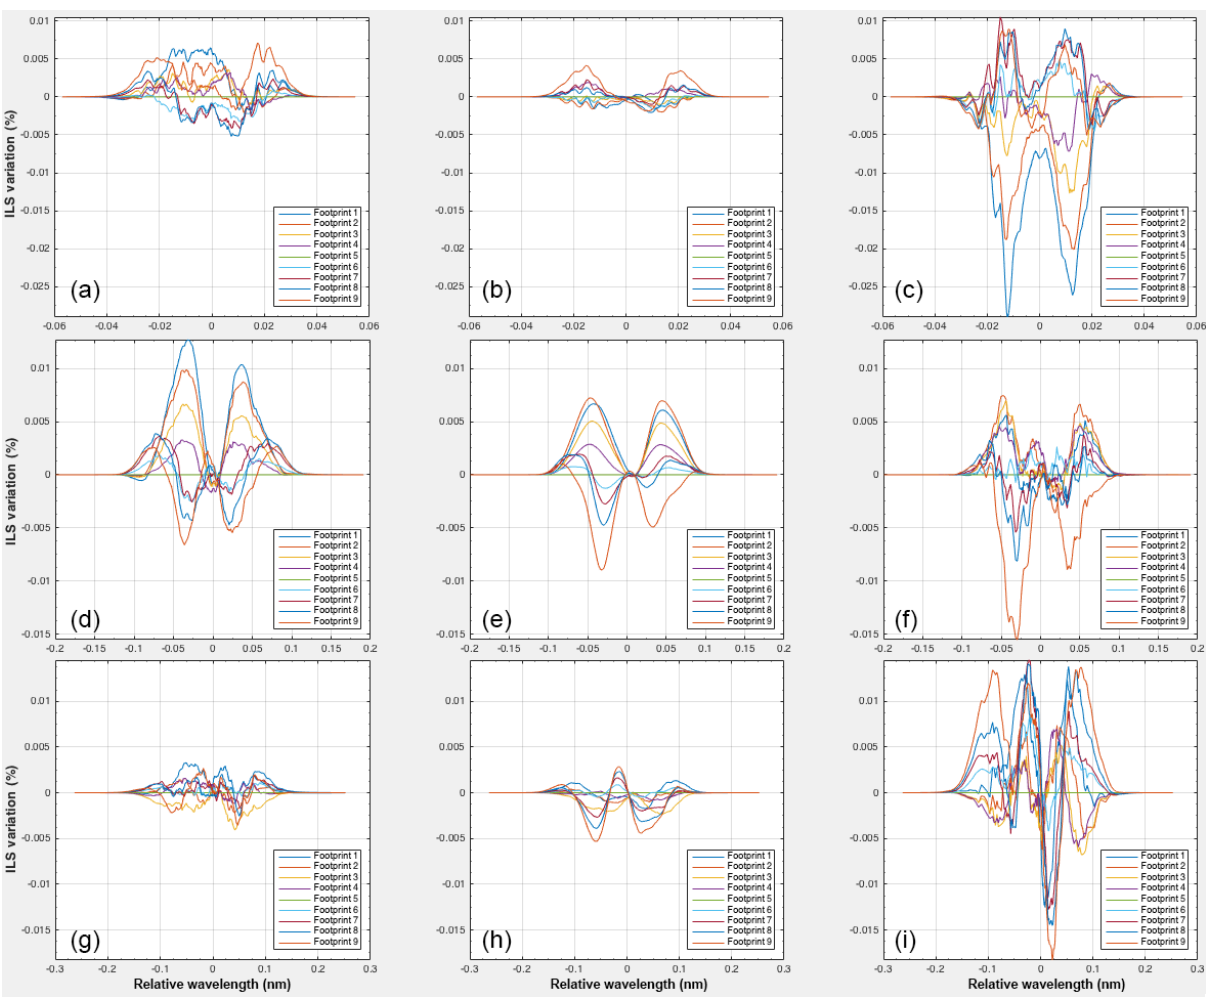
Figure 4. The ILS bias between the center of footprint 5 and the other footprints in the first, center, and last channels in the three bands. The top row is the O 2 A-band, the middle row is the WCO 2 band, and the bottom row is the SCO 2 band. The left column is the first channel in the three bands, the middle column is the center channel, and the right column is the last channel in the three bands. Different colors represent the ILS biases between footprint 5 and different footprints.